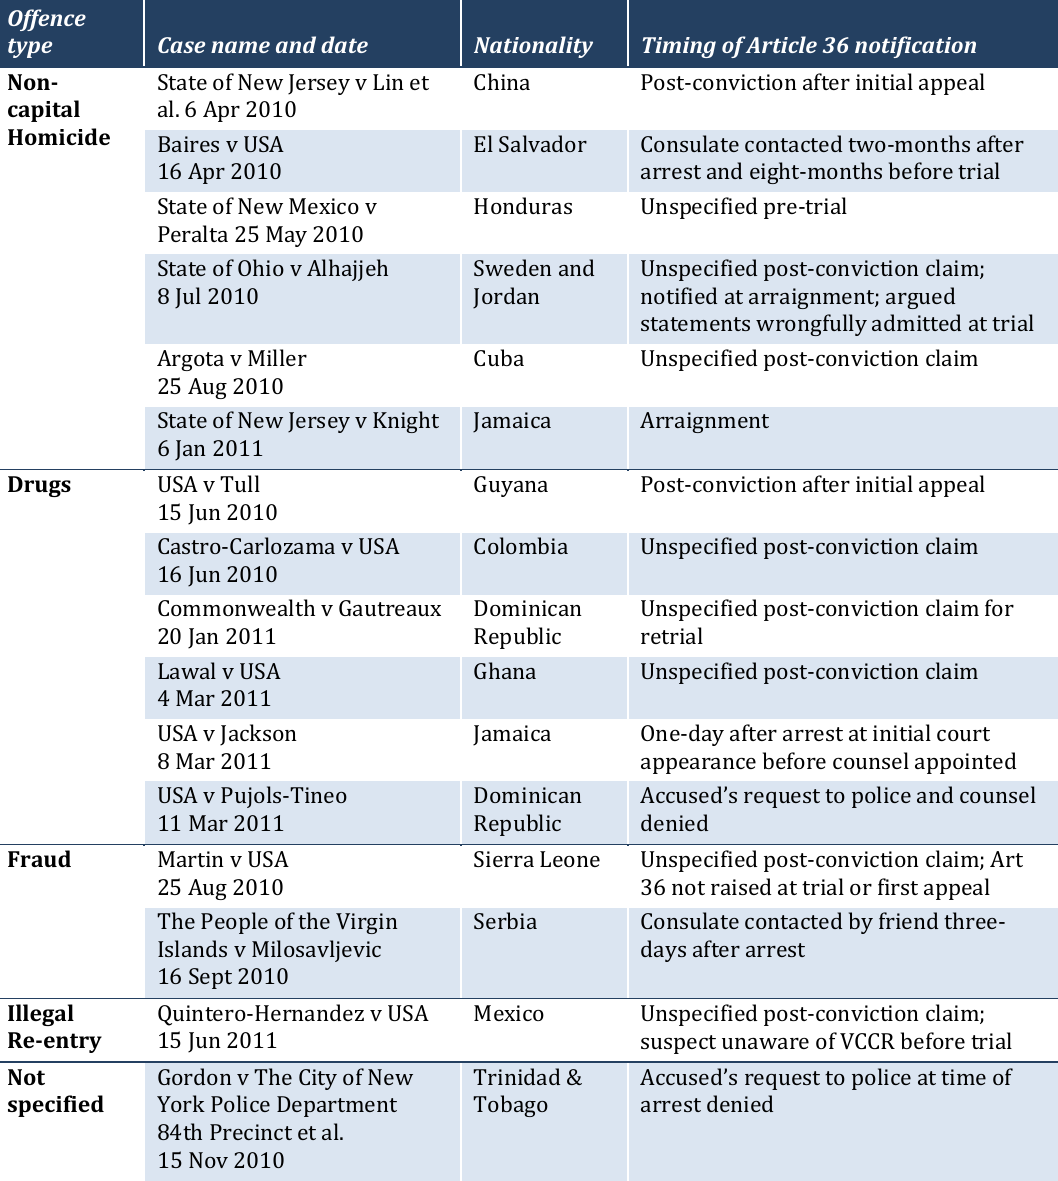
Table 3. US Article 36 claims, January 2010 ‐ July 2011, by country of citizenship and timing of